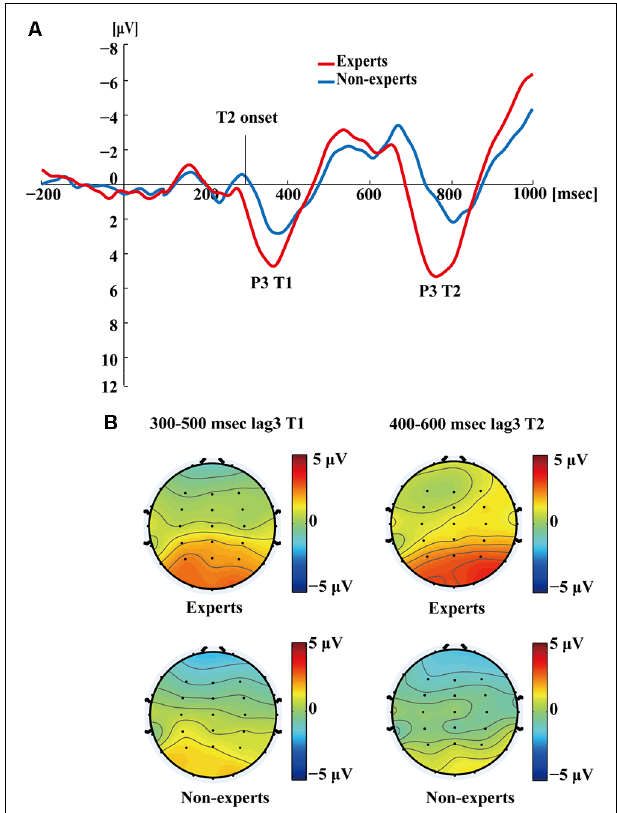
FIGURE 5 | (A) Grand averages of the mean activation at Pz of experts and non-experts as a function of time for lag3 trials during which an attentional blink did not occur (nonblink trials). Owing to the onset proximity of T1 and T2, we drew the waves induced by both targets together. ERPs were time locked to the onset of T1. (B) The scalp distribution of 300–500 ms time windows for dual-target condition at lag3 for T1. The scalp distribution of 400–600 ms time windows for dual-target condition at lag3 for